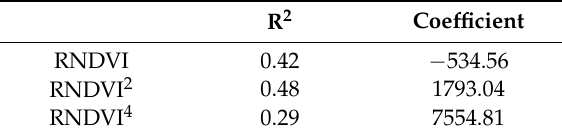
Figure 7. RNDVI in China in 2006. Table 1. Results of different order regressions between DN − 20 and RNDVI for the 2006 RCNL image.